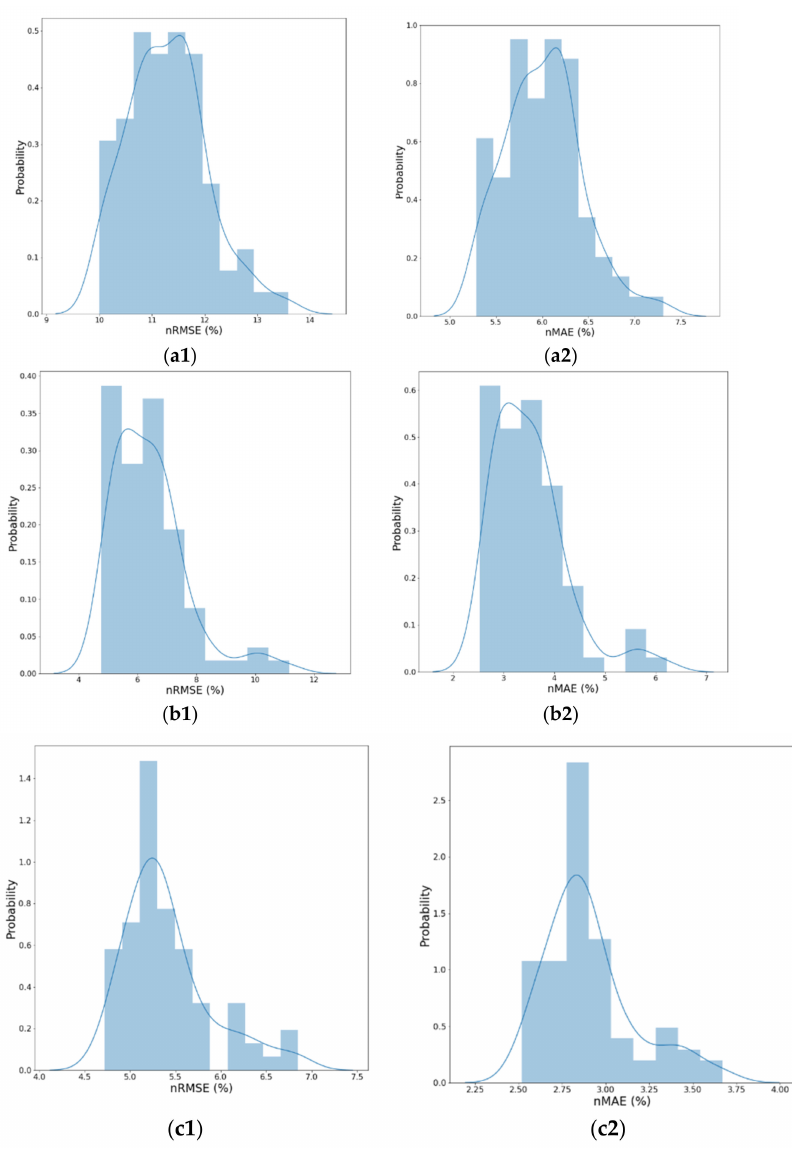
Figure 10. Regional PV output forecasting distributions; ( a1 ) nRMSE of Case 1 ( a2 ) nMAE of Case 1 ( b1 ) nRMSE of Case 2 ( b2 ) nMAE of Case2 ( c1 ) nRMSE of Case 3 ( c2 ) nMAE of Case